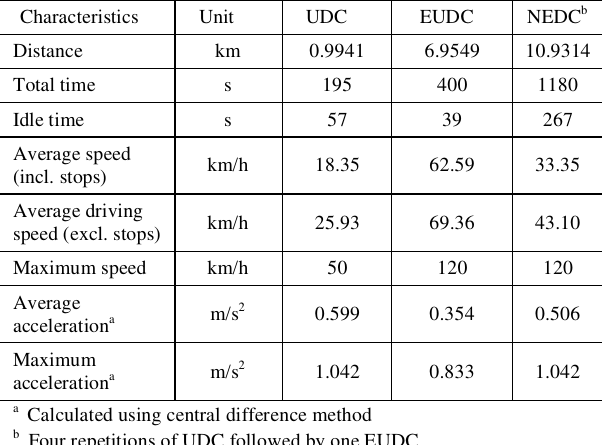
Table 2. Characteristics of UDC, EUDC and NEDC test